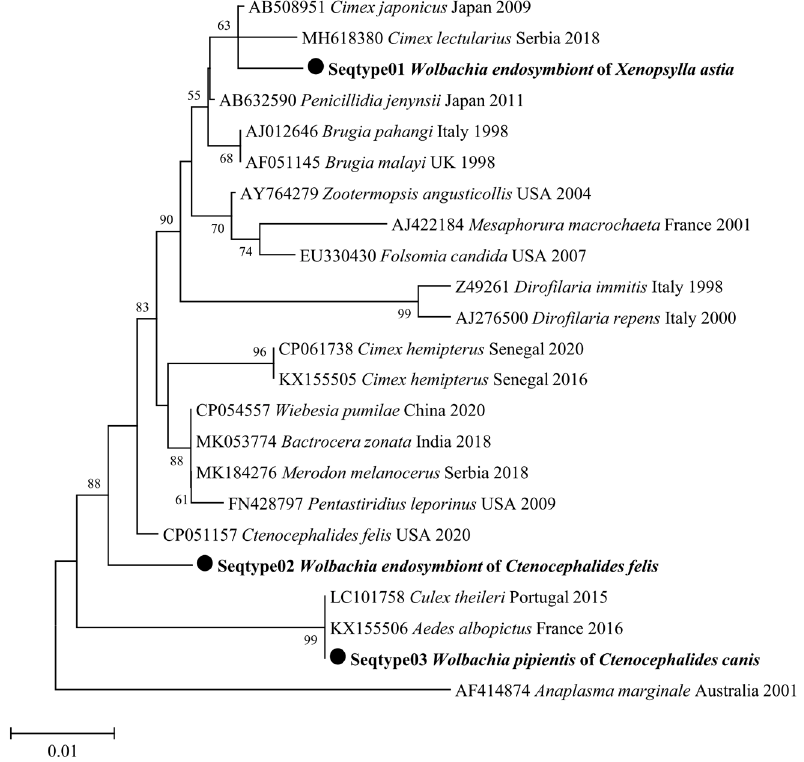
Figure 3. Neighbour-joining (NJ; 500 bootstrap replicates) phylogenetic tree of the 16S rRNA gene. Figure 3. Neighbour ‐ joining (NJ; 500 bootstrap replicates) phylogenetic tree of the 16S rRNA gene. Wolbachia spp. ( • ) collected from Xenopsylla astia , C. felis , and C. canis . Wolbachia strains are designated Wolbachia spp. ( ) collected from Xenopsylla astia , Ct. felis , and Ct. canis . Wolbachia strains are following the names of their host designated following the names of their host species.